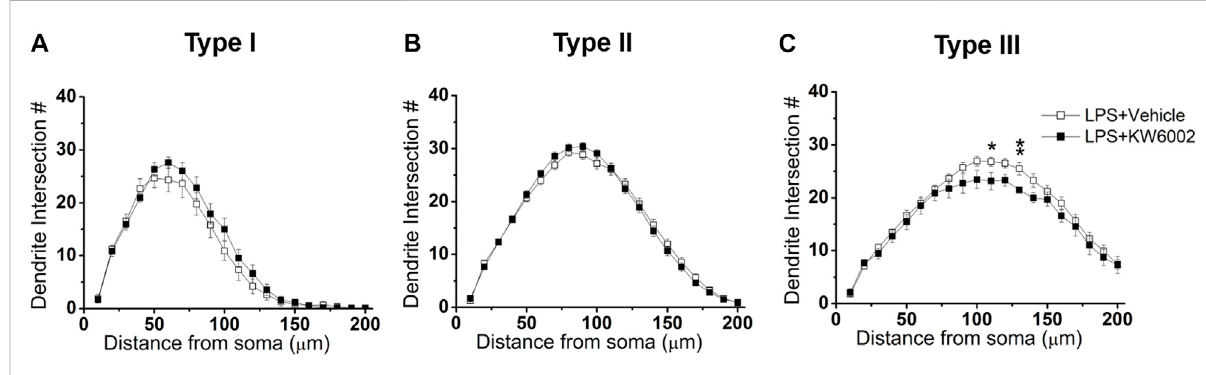
FIGURE 8 KW6002 decreased the dendritic complexity of Type III RGCs after neonatal LPS exposure. (A – C) Quantitative Sholl analysis of dendrite intersection numbers in each RGC type from the vehicle-treated and KW6002-treated group after neonatal LPS exposure. Data represent mean ± SEM. * p < 0.05; ** p <